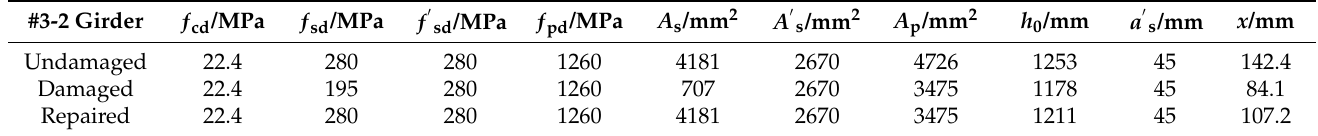
Table 1. Parameters for calculating the bearing capacity of the #3-2 girder in its undamaged, damaged and repaired states.